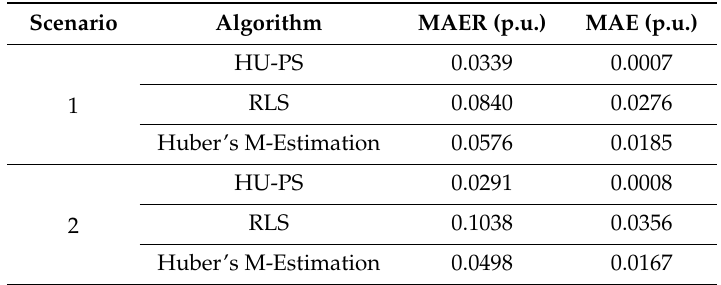
Table 1. Errors of TEPs estimation in case 1.